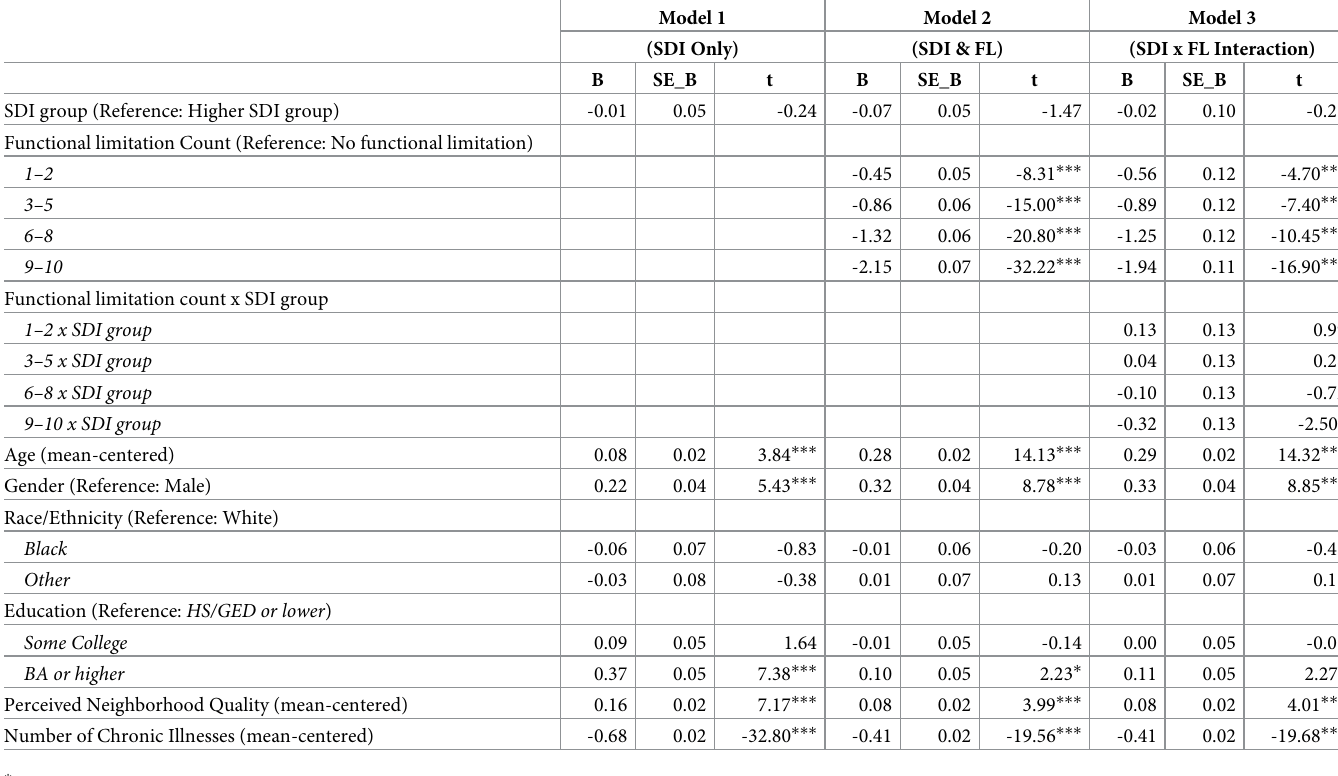
Table 2. Stepwise regression models regressing self-rated health by SDI group, functional limitation count, and their